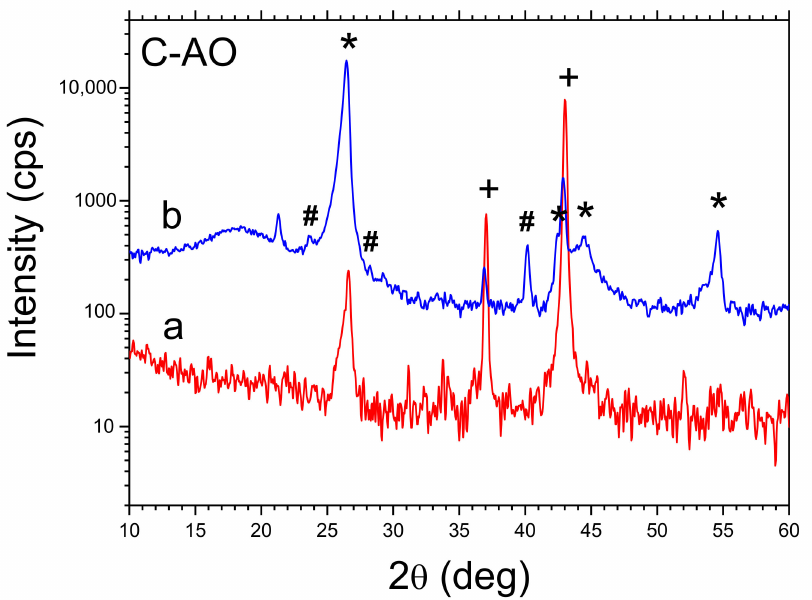
Figure 2. XRD patterns of C-AO (ammonium oxalate), a—raw reaction product, b—cleaned. Symbols: * graphite, + MgO, # Mg 2 Si.